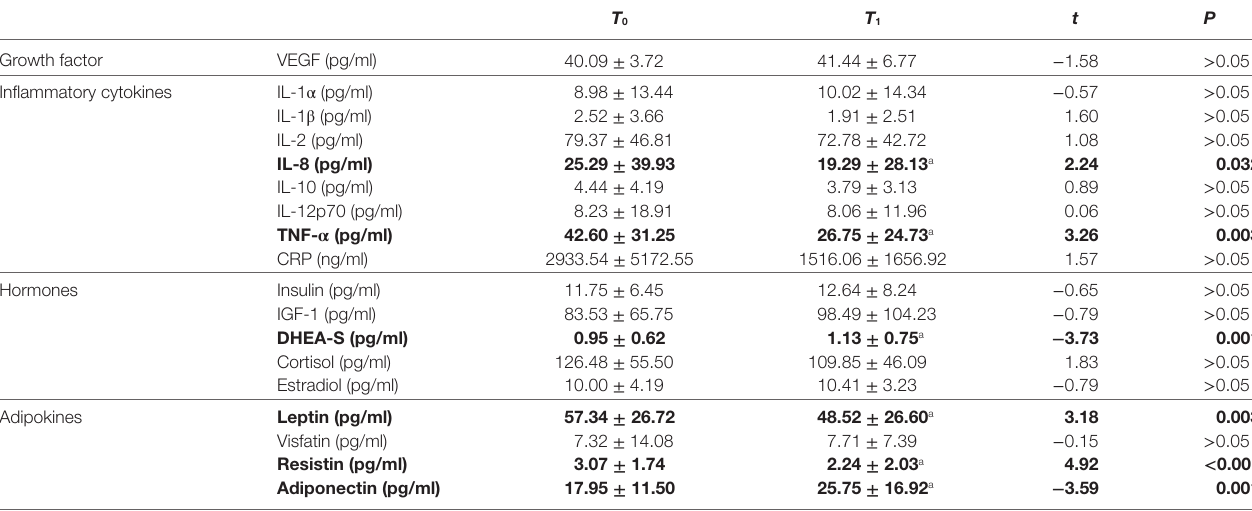
Table 2 | Cytokine, hormone, and adipokine levels before ( T 0 ) and after ( T 1 ) the intervention